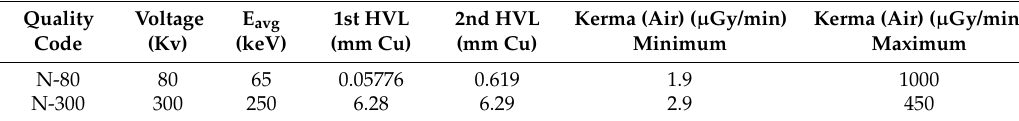
Table 5. Main features for N-80 and N-300 Qualities.